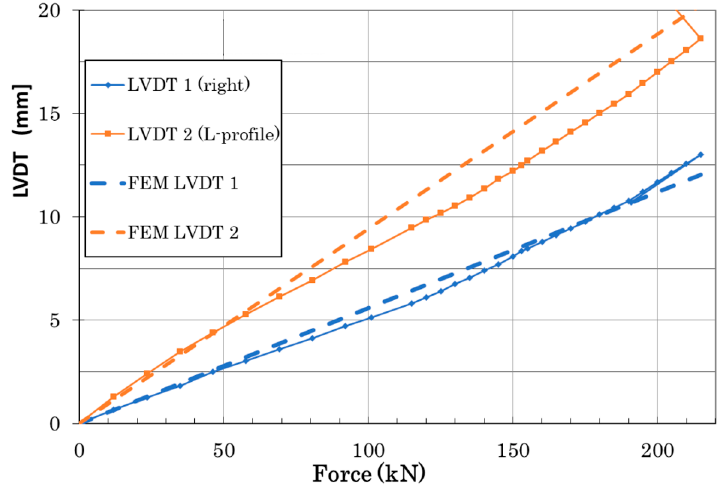
Figure 16. Force vs. LVDT displacement comparison of experimental data and numerical predictions.